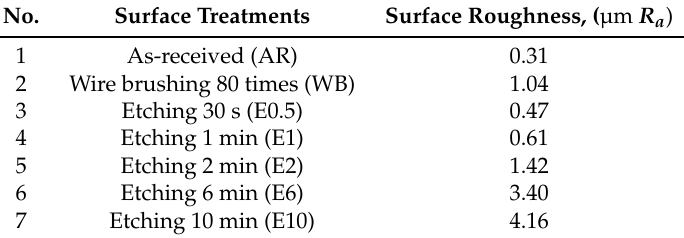
Table 3. Surface roughness, R a for different surface treatments.